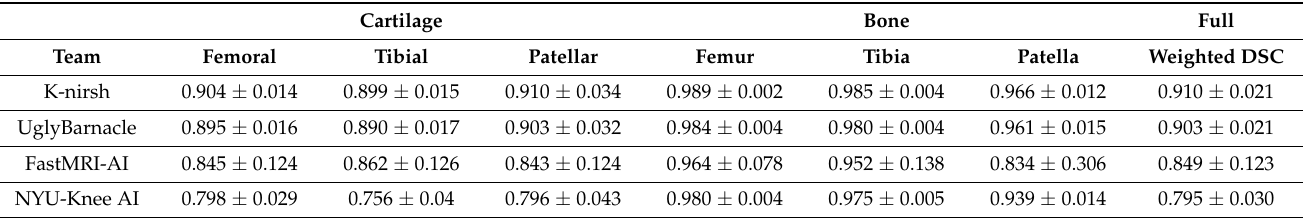
Table 2. Segmentation performance across test set (n = 50) for each of the top 4 pipelines, stratified by tissue compartment. Results are presented mean ± 1 s.d. K-nirsh showed the strongest results in each tissue compartment and overall, and is shown in bold. Cartilage Bone Full